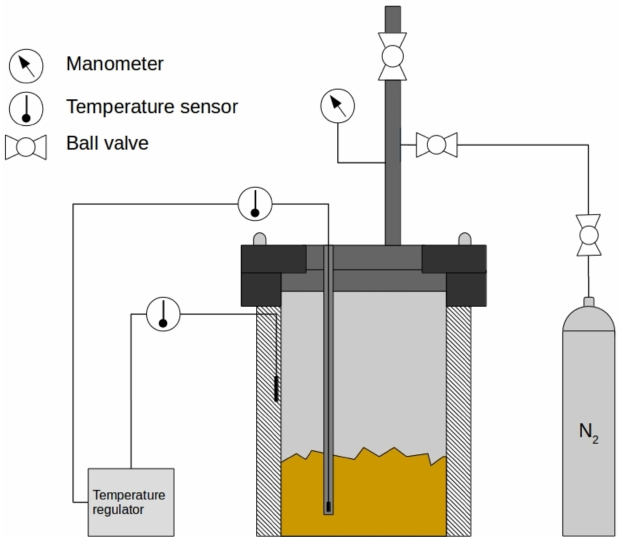
Figure 2. Used pretreatment reactor with temperature control unit (heating regulated by two tem- perature sensors), pressure release valve (on top of reactor), and attached nitrogen bottle (N 2 ). The dashed area symbolizes heating jacket, the brown area symbolizes biomass–water mixture, the black area symbolizes the tightening clamps of the reactor, and the dark-grey area symbolizes the reactor cap (figure modified from